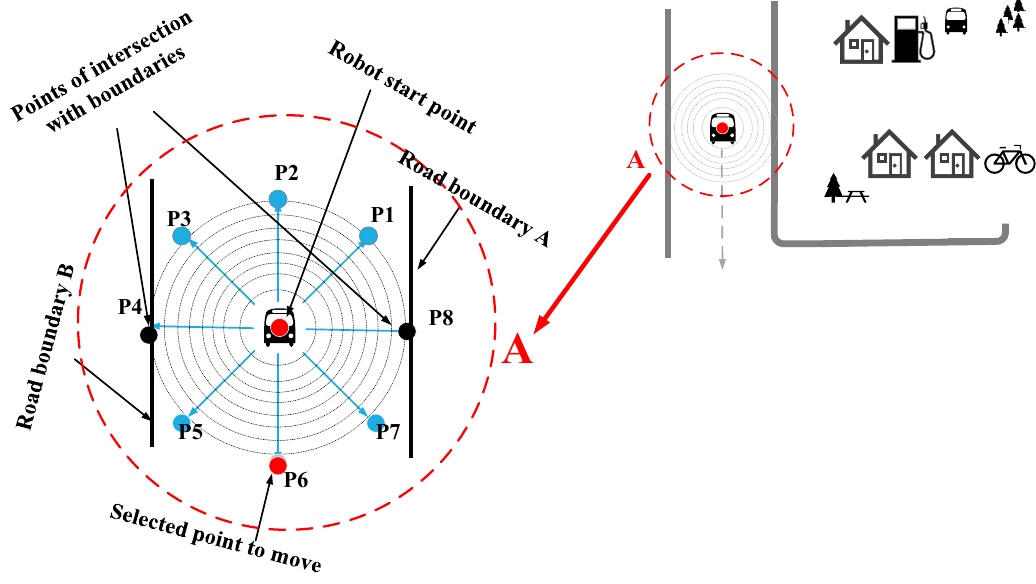
Figure 2. GLS method